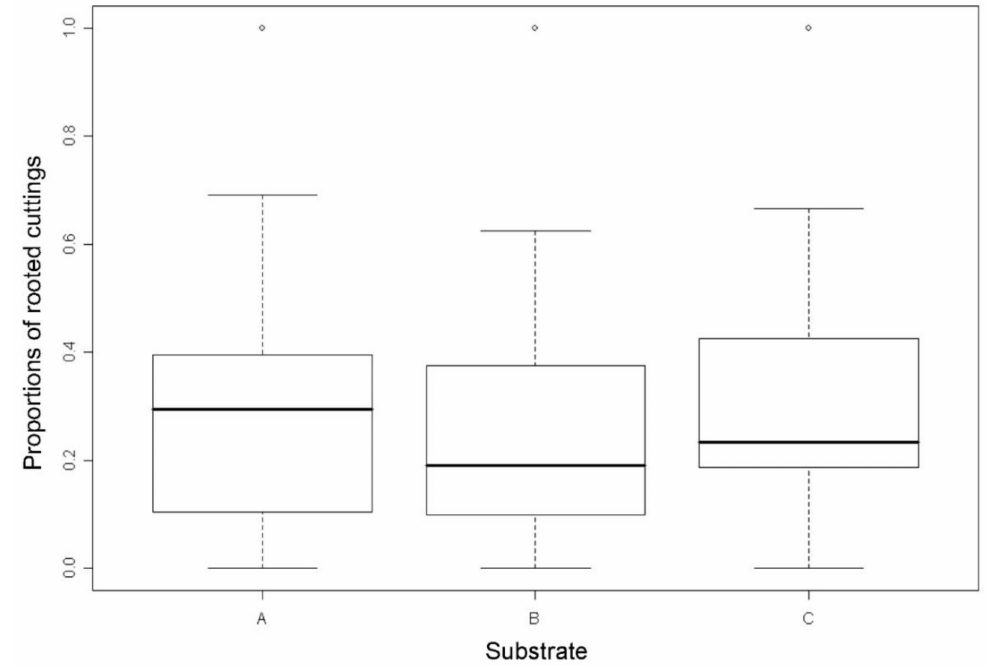
Figure 7. Box plot of the proportions of rooted cuttings from the surviving cuttings in relation to the substrate. The horizontal line in each box represents the median, the hinges represent the 25th and 75th percentiles, the whiskers represent 1.5 times the interquartile range and open circles represent values outside this interval.